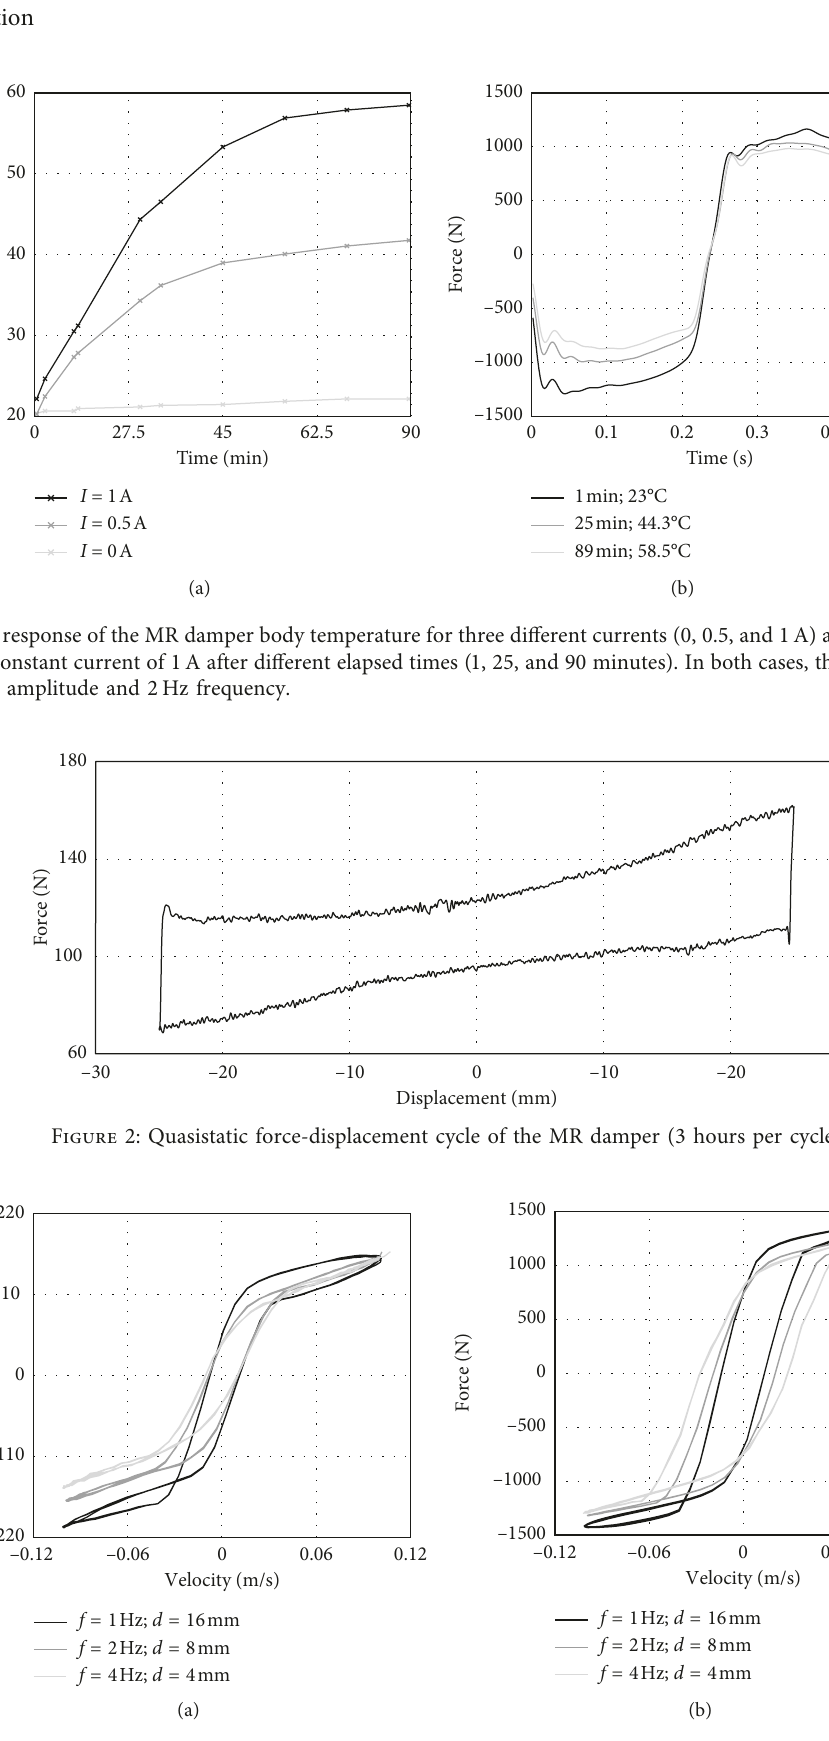
0A, (b) I (cid:31) (cid:31)